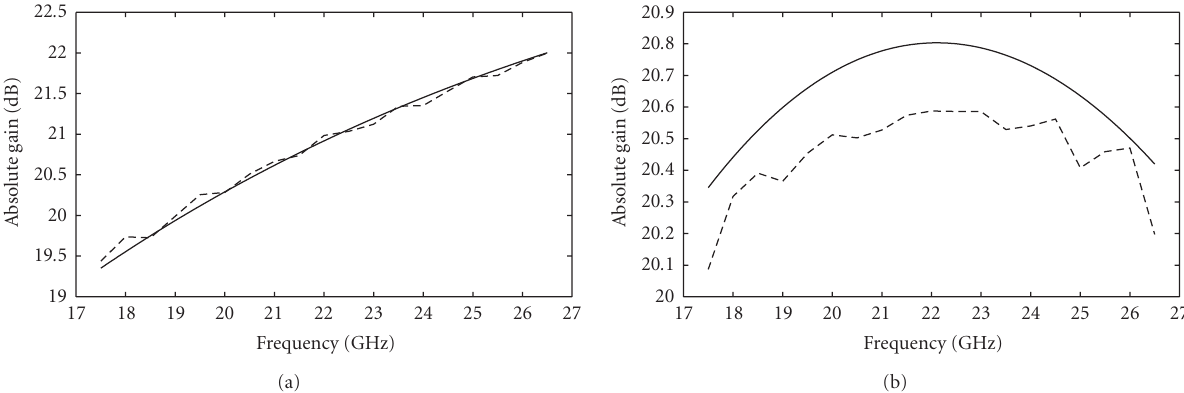
Figure 3: Gain pattern for a K -band conical horn. (a) D = 6.02 cm (optimum aperture diameter), (b) D = 8.20 cm (greater than maximum aperture diameter required for normal gain pattern). The solid line is obtained by using approximate gain formula [3]. The dashed line is simulated by using CST Microwave